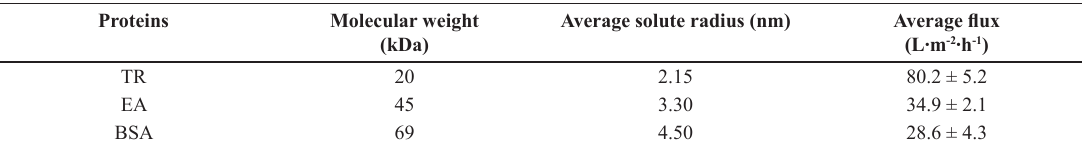
Table 1 - Permeate flux presented by membranes for the different proteins used in this study . The fluxes were measured at transmembrane pressure of 100